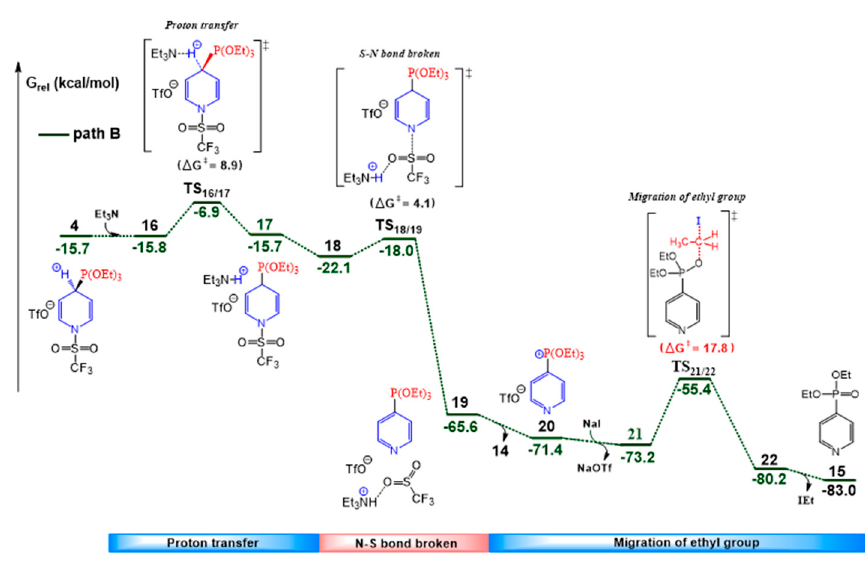
Figure 3. Free energy profile of dihydropyridine rearomatization to afford the final product (path B).